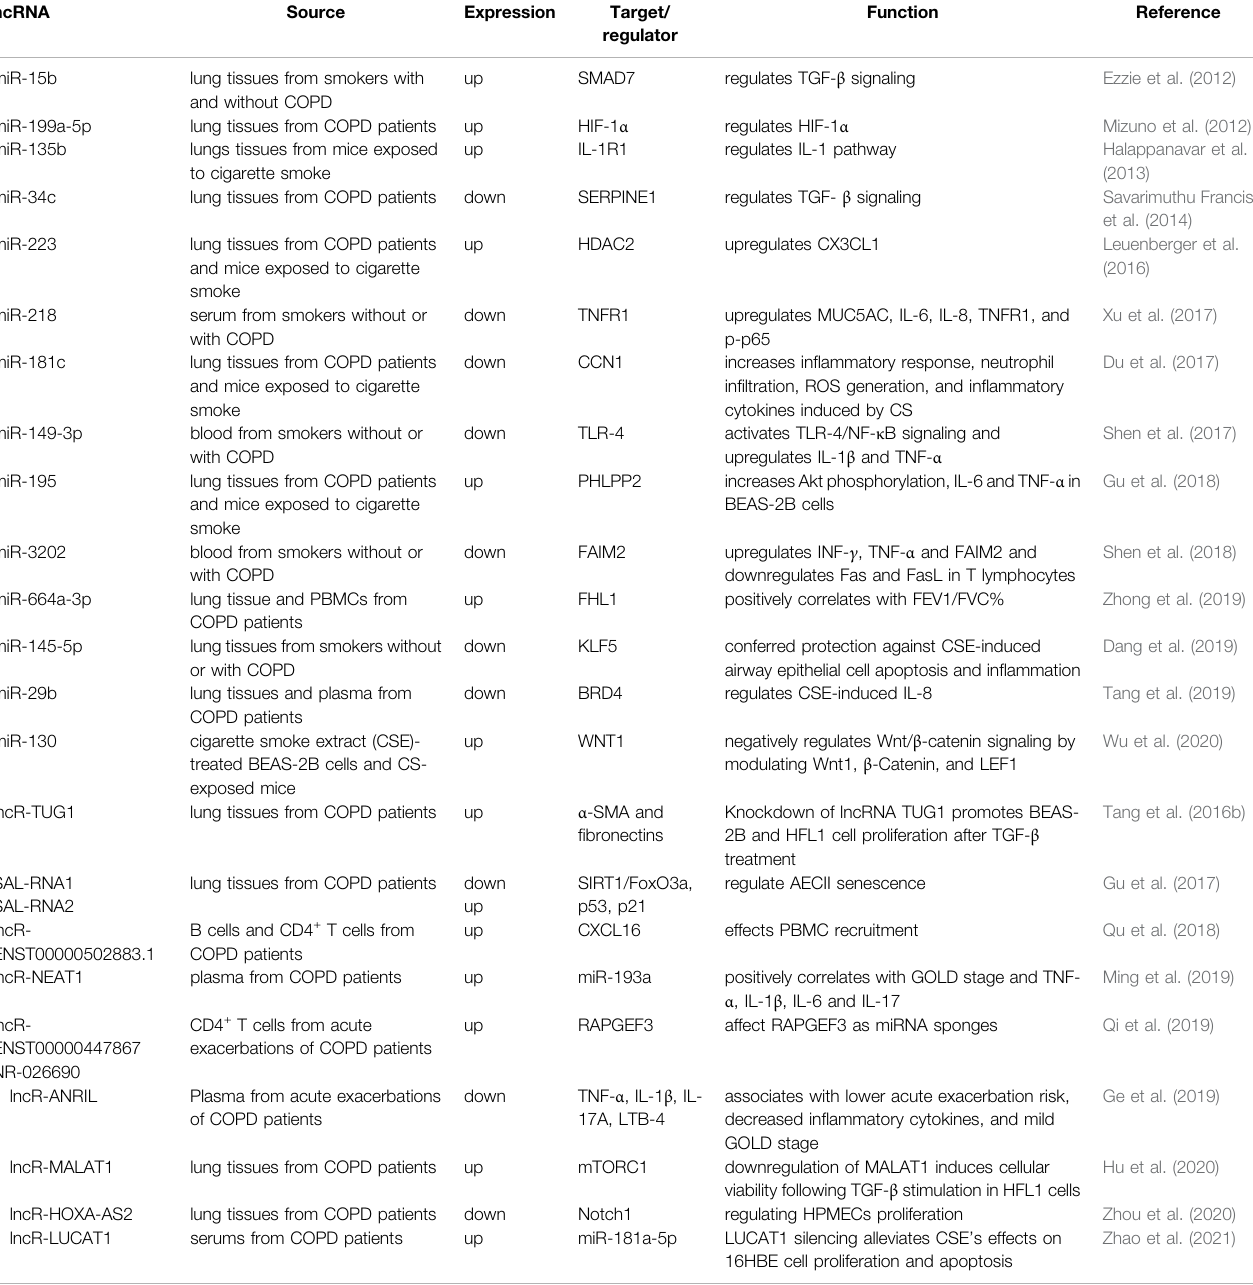
TABLE 2 | List of ncRNAs and their targets and functions in COPD.